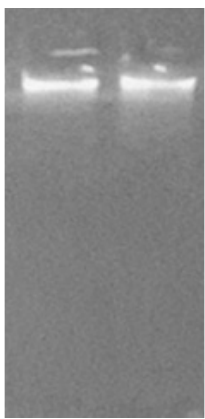
Fig. 1. DNA of P.floridanus (Lane 1) and P.djamor Fig. 2. PCR result of the two whit rot fungi Lane 1:100Kbs Ladder. Lane 2: P.floridanus Lane 3: P.djamor